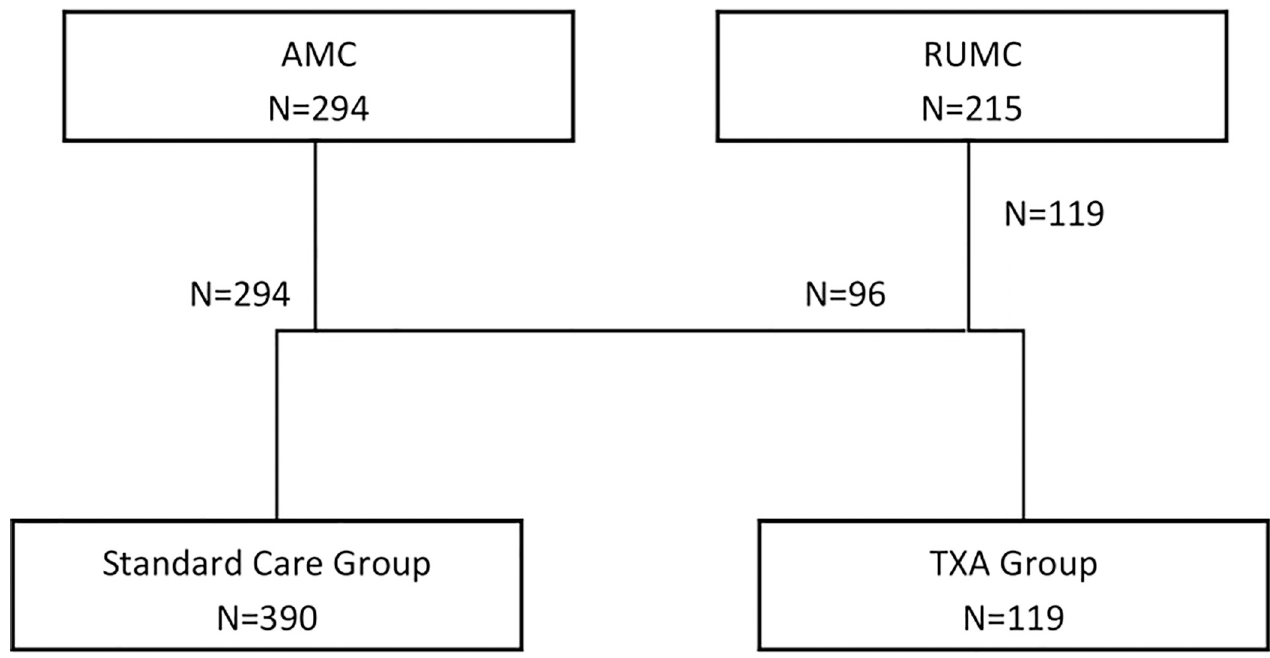
Fig 1. Flowchart allocation per treatment